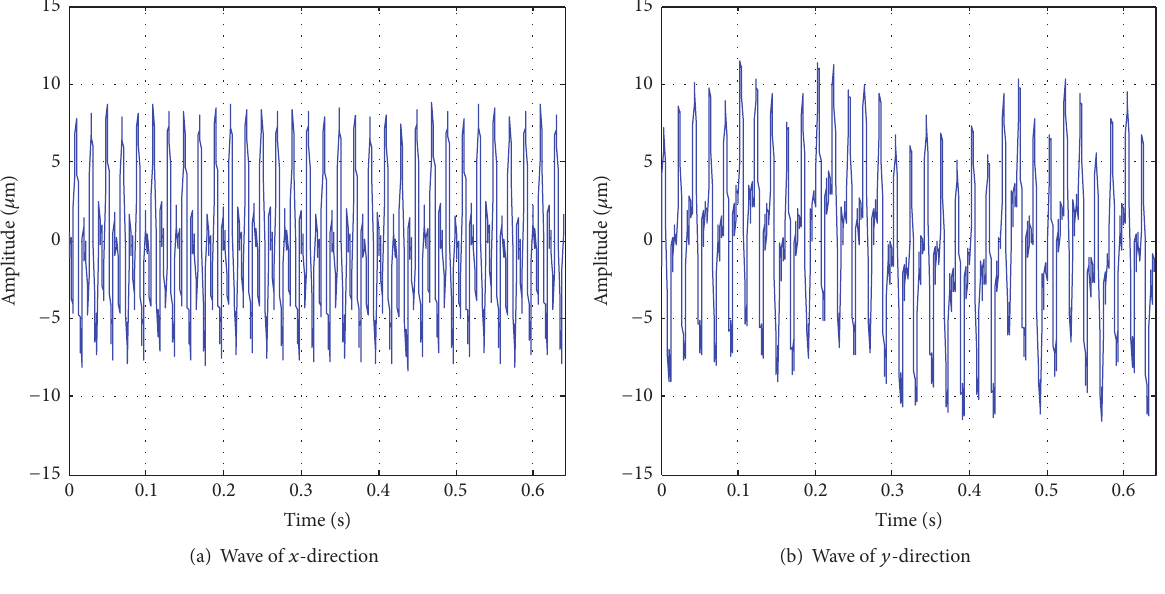
Figure 7: Vibration wave of 𝑥 and 𝑦 direction of the same cross section.